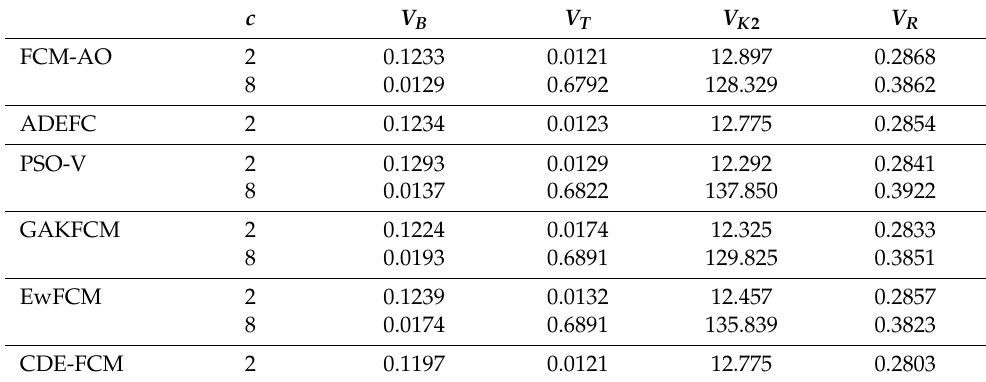
Table 5. Performance of algorithms on cancer data.